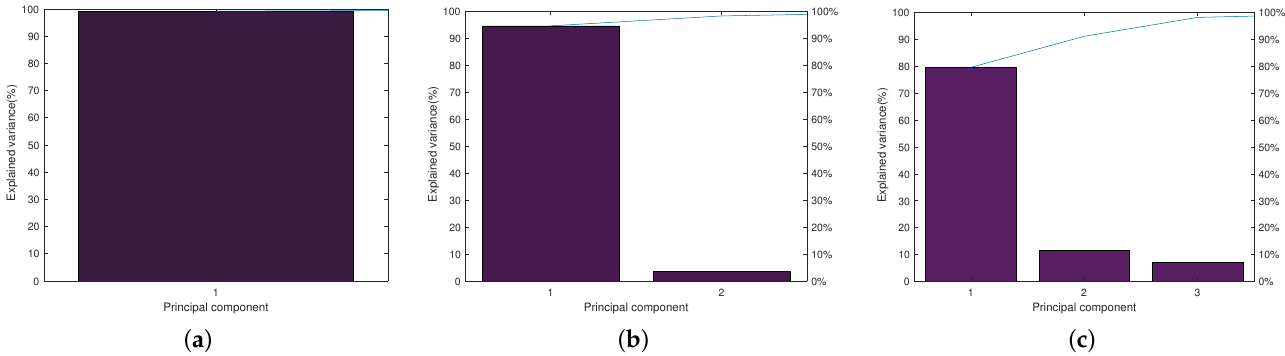
Figure 7. Pareto chart of the variance explained by the first principal components, ( a ) torque signals, ( b ) stator current signals, and ( c ) speed